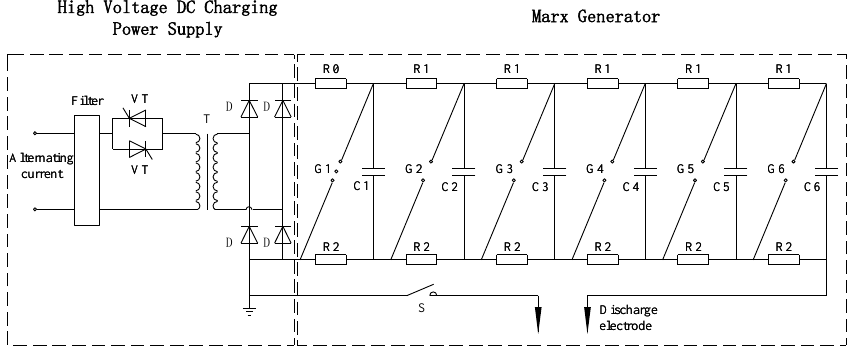
Figure 2. Circuit schematic diagram of a Marx generator: VT—thyristor, T—transformer, D—rectifier, R0—isolation resistance, R1—charge resistance, R2—protection resistor, G1,G2,G3,G4,G5,G6—spark gap, C1,C2,C3,C4,C5,C6—storage capacitor, S—high-voltage pulse switch.